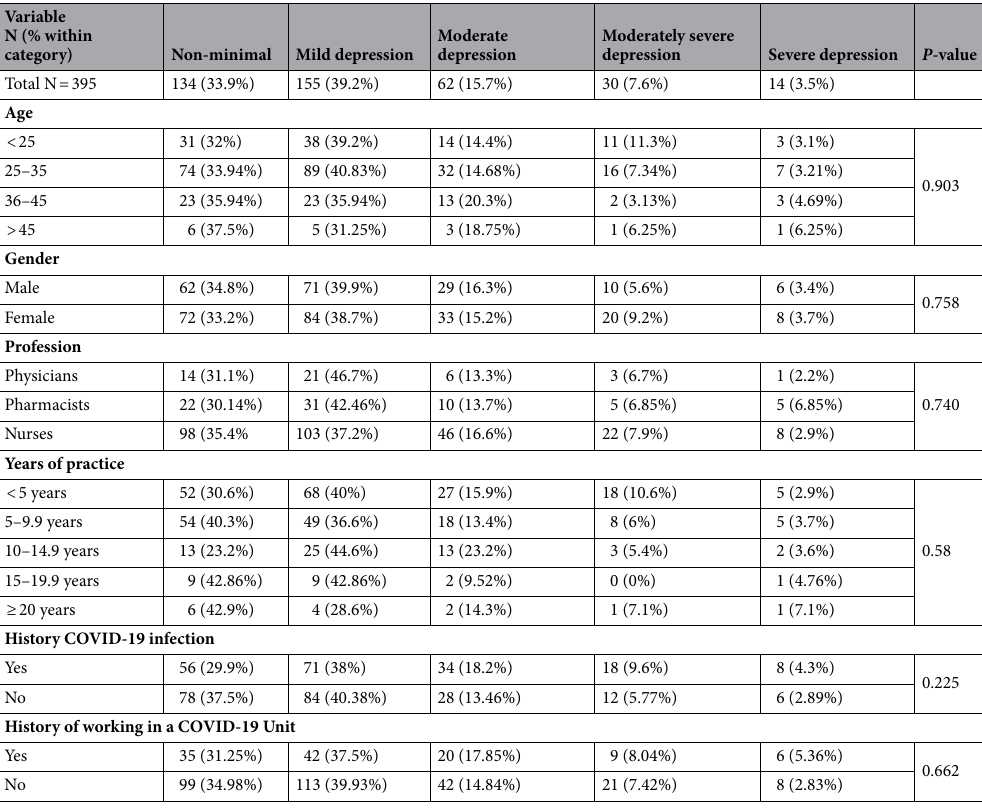
Table 4. The level of depression among HCWs (using PH-Q9